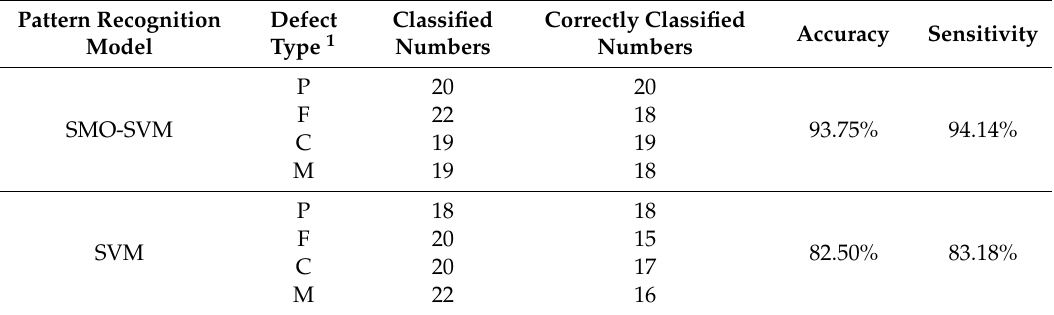
Table 1. The results of insulation defect identification based on ultrasonic signals of